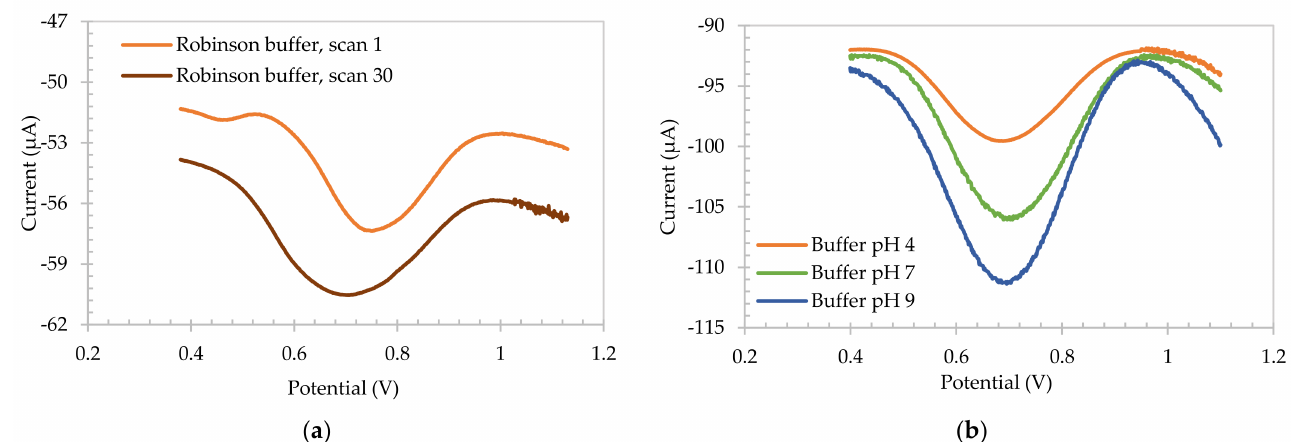
Figure 1. ( a ) Square Wave Voltammetry of scan 1 and scan 30 of reductive electropolymerization of salicylic acid carbon-based electrode when placed in pH 2 Britton-Robinson buffer. ( b ) The resulting electropolymerized layer when placed in pH 4, pH 7 and pH 9 IUPAC standard